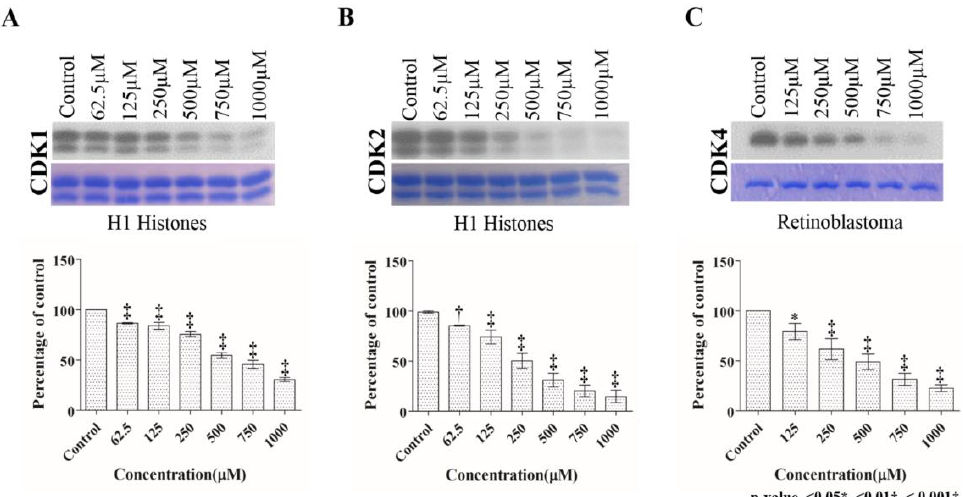
Figure 2. ( A ), ( B ) and ( C ) show the dose dependent effects of 2,4,6-THBA on CDK1, CDK2 and CDK4 enzyme activity respectively. H1 histones were used as the substrate for CDK1 and CDK2, while retinoblastoma protein was used as the substrate for CDK4. Upper panel shows phosphorylation of H1 histones (CDK1 and CDK2) and retinoblastoma protein (CDK4) in the presence of different concentrations of 2,4,6-THBA. The middle panel shows the Coomassie Blue stained proteins. Lower panel represents the quantification of the bands in upper panel.